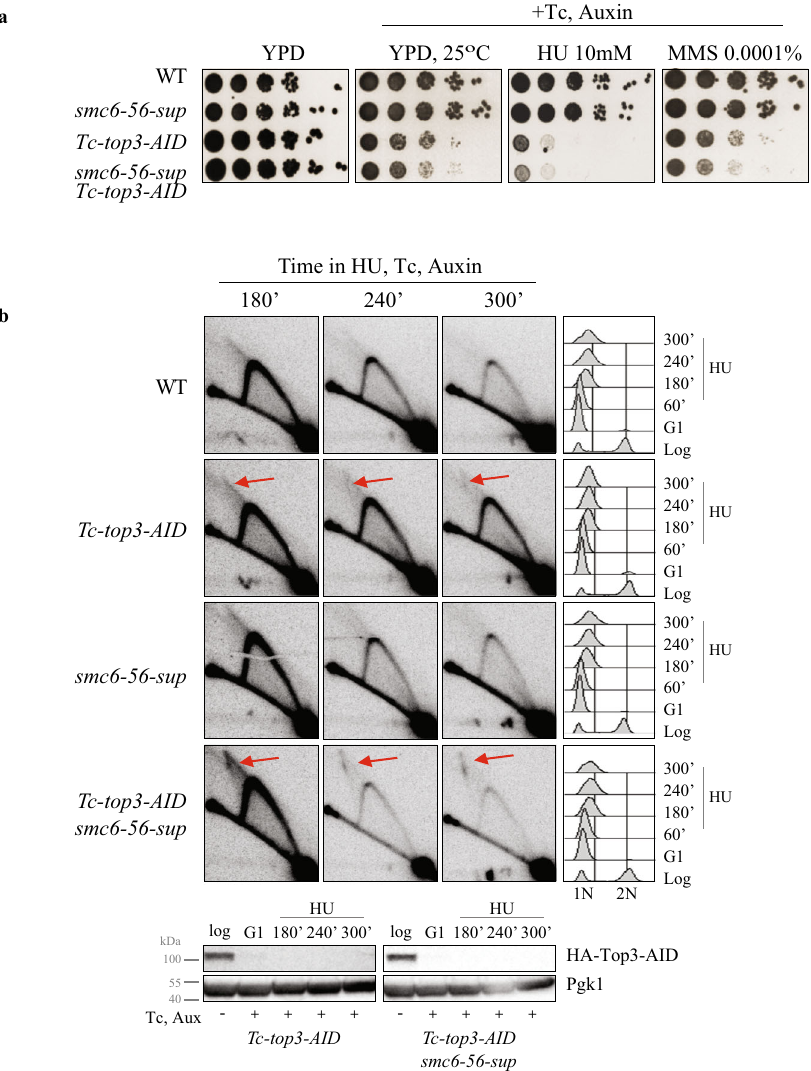
Fig. 6 Smc6-56-sup is defective in pathways that act complementarily with Top3 to prevent JM accumulation. a Additivity between smc6-56-sup and Top3 depletion induced by tetracycline (Tc) and auxin addition to Tc-top3-AID . b 2D gel of replication intermediates arising at TER302 in cells released synchronously from G1 in media containing 200 mM HU, tetracycline (Tc) and auxin. The experiment was repeated independently twice with similar results. Flow cytometry pro fi les are indicated on the right. Joint molecules accumulating on the X-arc are indicated by red arrows. Source data are provided as a Source Data fi